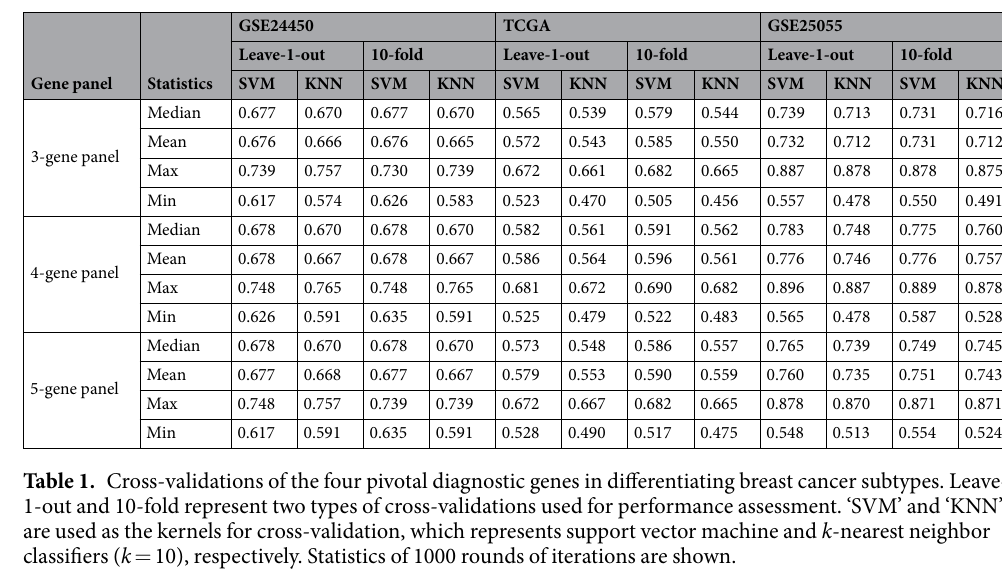
(Supplementary Figure S4). We thus consider the 4-gene panel as pivotal genes for the subsequent analyses and discussions. Hierarchical clustering analysis. Four subtypes, [ER + |PR + ]HER2 − , [ER + |PR + ]HER2 + , [ER − |PR − ]HER2 + , [ER − |PR − ]HER2- (also named TNG), were defined based on the status of ER, PR and HER2, convention- ally used in clinic. Using only the four pivotal diagnostic markers, ER- tumors (red and yellow), especially the [ER − |PR − ]HER2 − cohort (red), could be clearly distinguished from ER + samples (green and blue) (Fig. 6) using GSE24450, TCGA and GSE25055 datasets. Patient sample stratification. Among the four genes, FAM134B and KIF1A function in differentiating ER pos- itive and ER negative subtypes. The p values are 3.10E-25 ( FAM134B ) and 3.66E-13 ( KIF1A ) using TCGA data; 2.71E-10 ( FAM134B ) and 4.83E-03 ( KIF1A ) using GSE24450; and 6.33E-03 ( FAM134B ) and 1.43E-05 ( KIF1A ) using GSE25055 (Fig. 7). ALCAM and KIF2C could nicely distinguish TNG from the rest. That is, the p values are